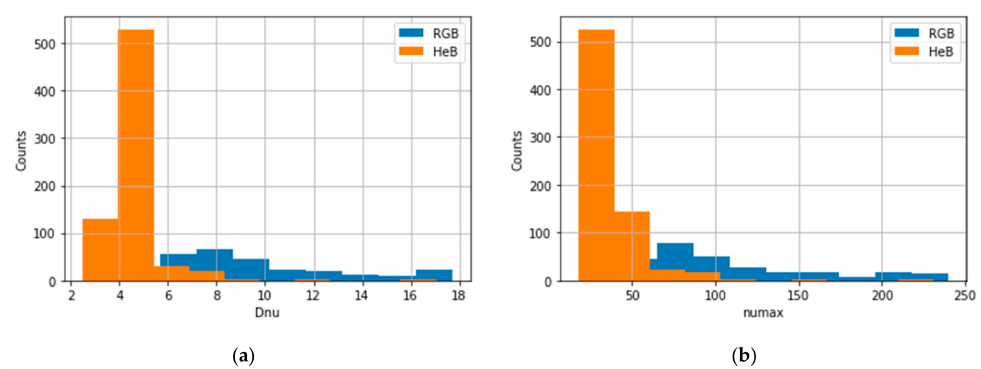
Figure 3. The asteroseismology feature analysis among the target category is listed as ( a ) the Dnu feature distribution analysis; ( b ) the Numax feature distribution analysis.